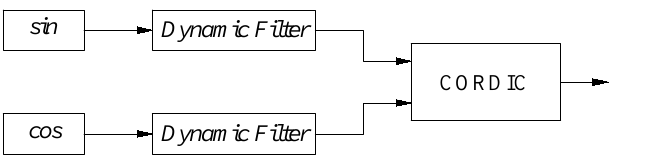
Figure 13. Schematic diagram of a hardware − in − the − loop simulation to prove that the filter does not cause phase abrupt changes.